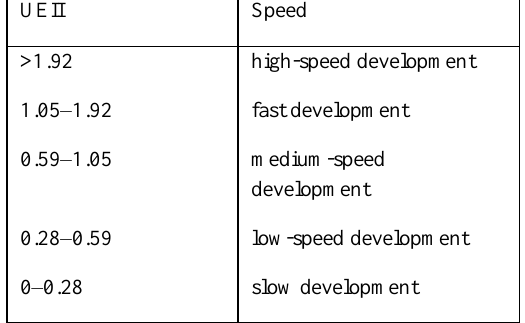
Table 3 . The division standard of